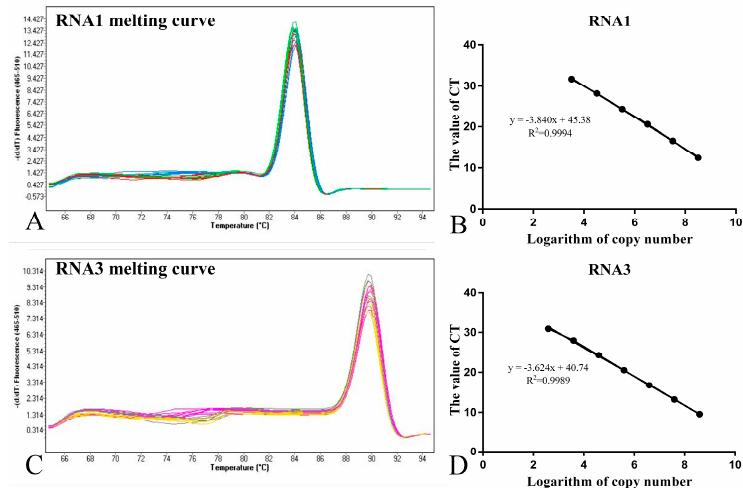
Figure 3. Melting temperature (Tm) and standard curve analyses after amplification of specific RNA1 and RNA3 templates using an SYBR Green I-based real-time PCR protocol. ( A ) Melting curve of RNA1; ( B ) Standard curve of RNA1; ( C ) Melting curve of RNA3; ( D ) Standard curve of RNA3.